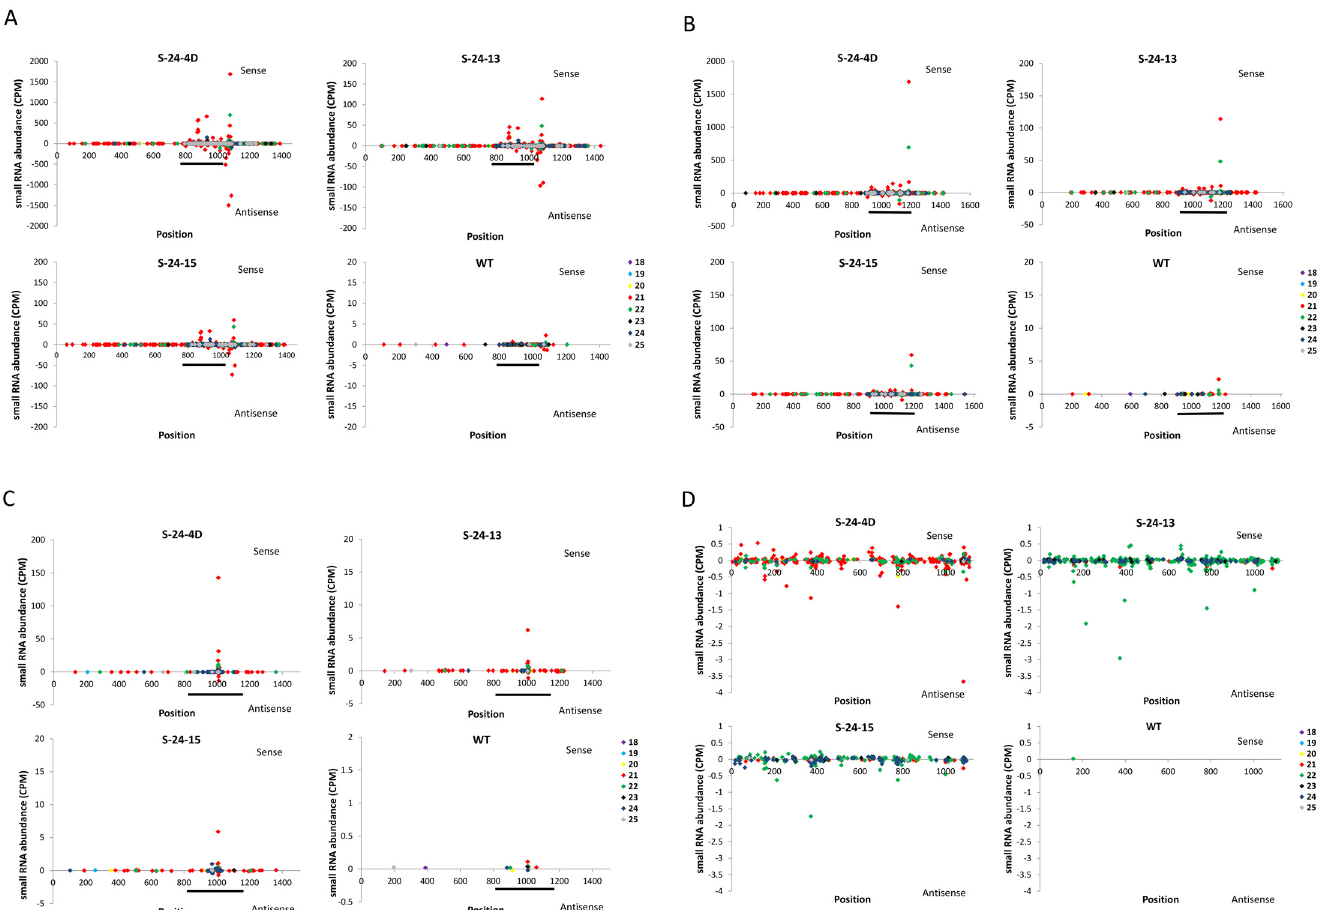
Fig 7. RNAi-induced transitivity. (A) — (D) Small RNAs matching the GmFAD3A , GmFAD3B , and GmFAD3C transcript sequences and the rice waxy-a intron were plotted versus the average of their normalized abundance from three replications, respectively. The 318-bp siRNA generating IR on GmFAD3A and corresponding target regions on GmFAD3B and GmFAD3C are indicated with black lines. For visual clarity, Y-axis of each diagram is adjusted according to the small RNA abundance.